Question: Produce a descriptive caption suitable for publication.
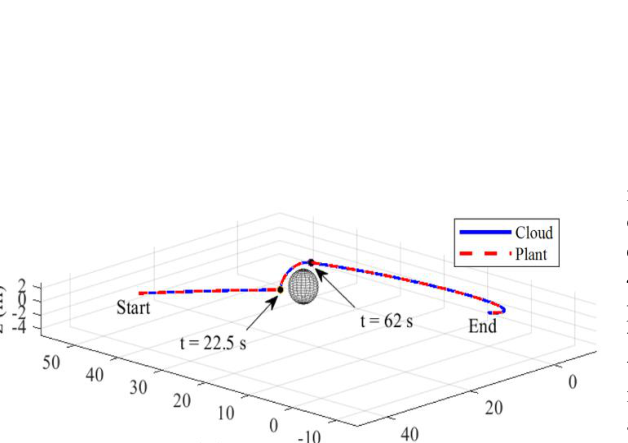
Answer: Comparison of obtained trajectory in 3D space